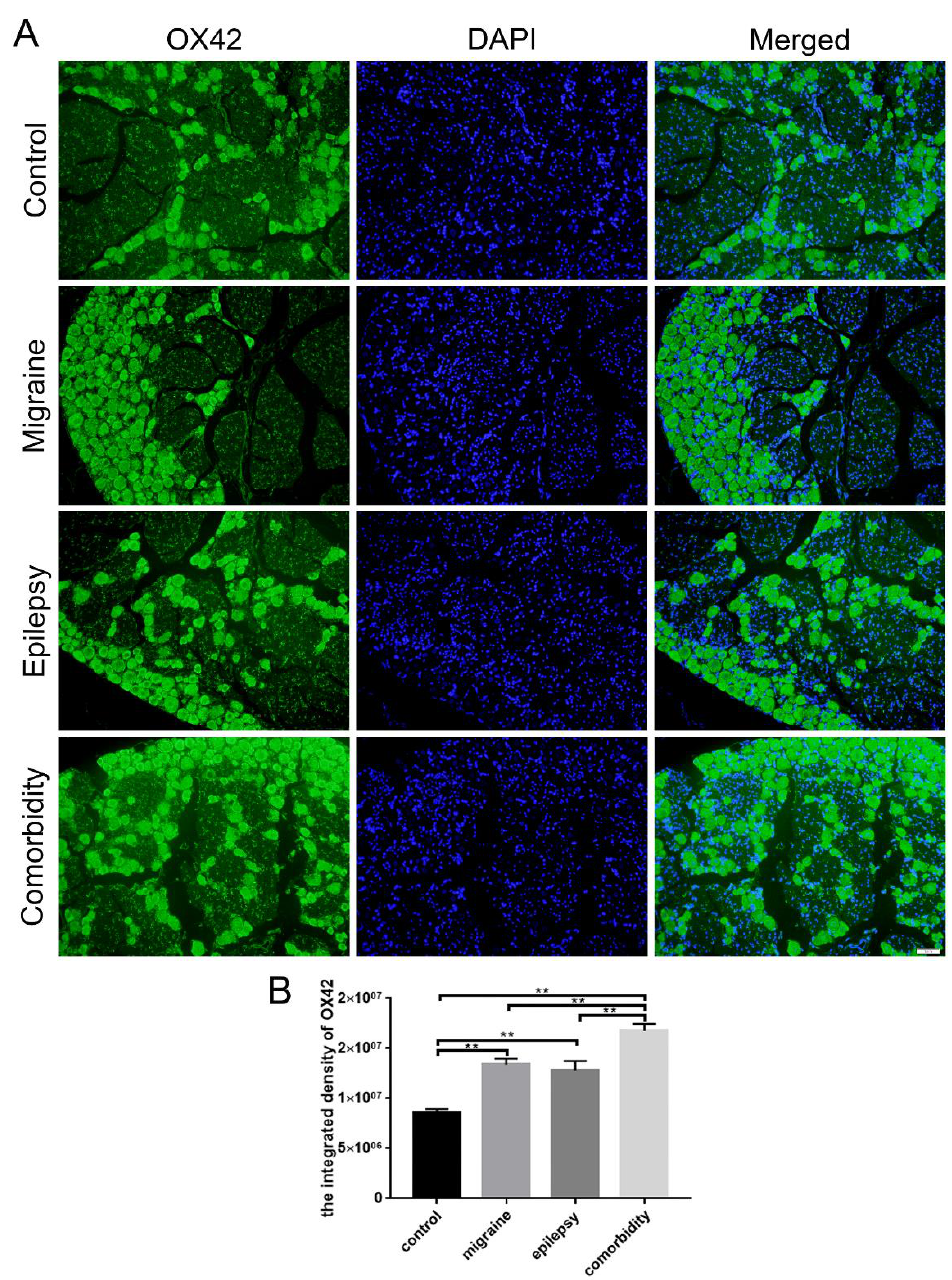
Figure 5. Localization of OX42 in the trigeminal ganglion in four groups. ( A ) OX42 (green) localized in the trigeminal ganglion in four groups. ( B ) Quantitative assessment of the integrated density of OX42 in the trigeminal ganglion ( n = 3, ** p < 0.01). DAPI (blue) indicates cell nuclei. The scale bar represents 50 µ